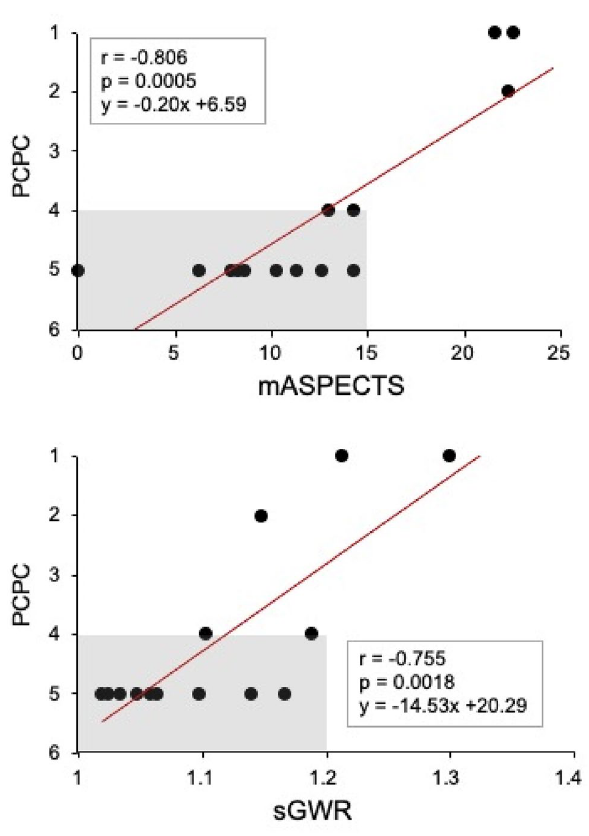
Figure 6. Correlation of the mASPECTS and sGWR with PCPC at 30 days after CA. Severe neurological disabilities (higher PCPC scores) among 14 survivors are correlated with lower mASPECTS (r = − 0.81, p = 0.0005) and sGWR values (correlation coefficient r = − 0.76, p = 0.0018). Shaded areas highlight the 11 patients with severe neurological disabilities (PCPC ≥